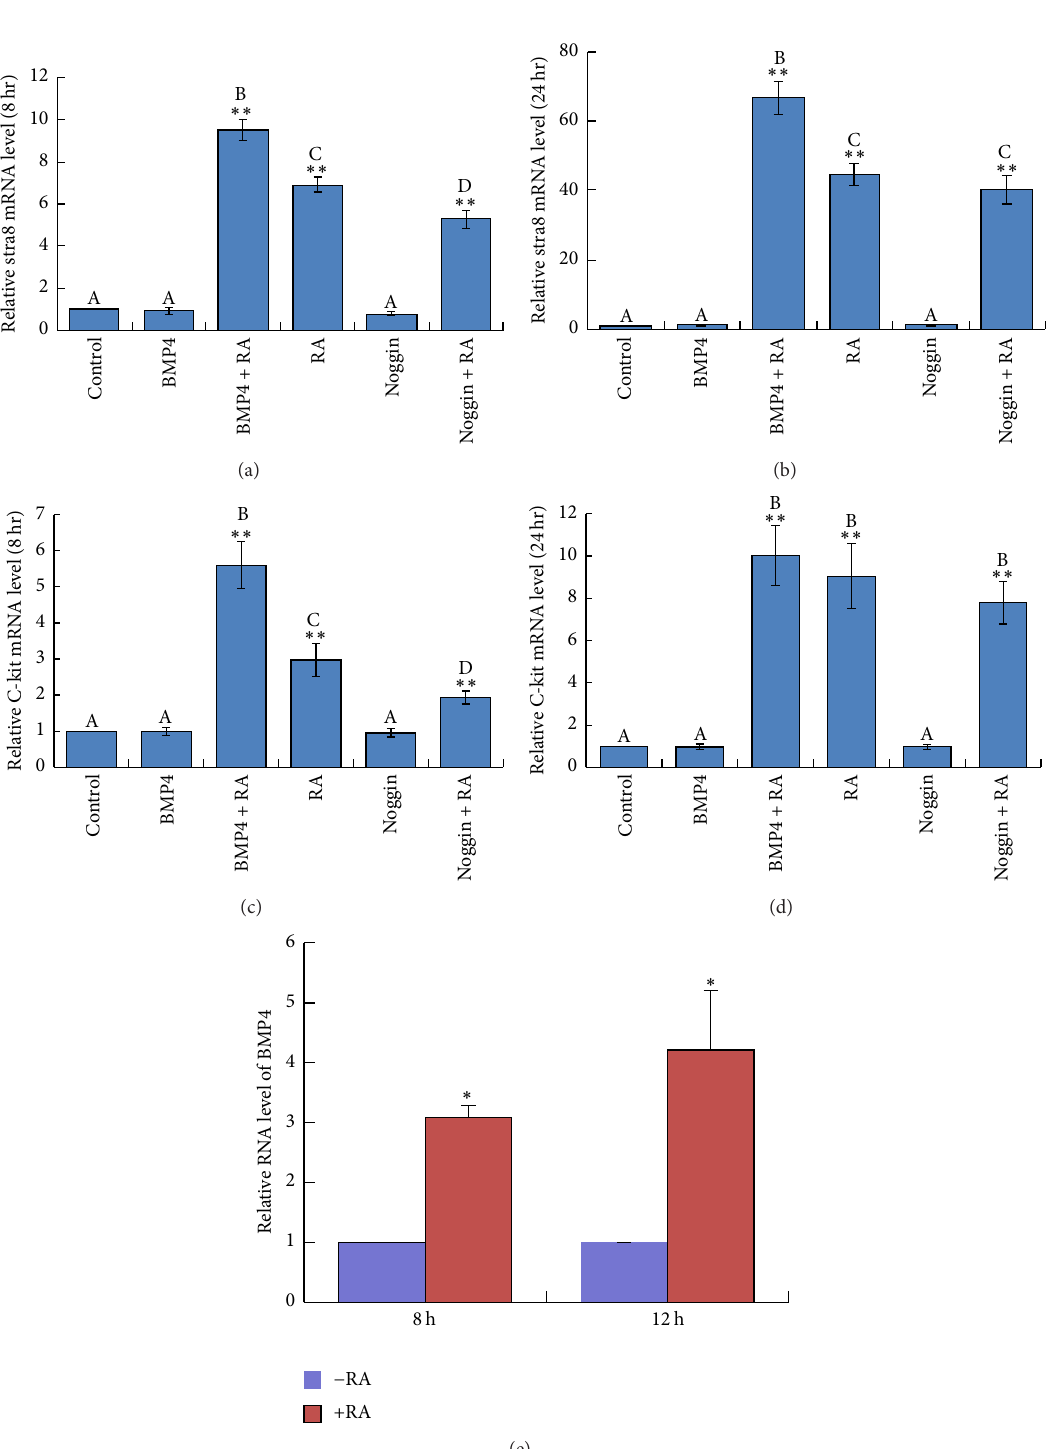
Figure 6: BMP4 induces the expression of Stra8 and c-Kit cooperatively with RA in cultured spermatogonia. (a-b) Real-time PCR analysis of Stra8 expression in cultured spermatogonia pretreated with BMP4 or Noggin and followed by RA stimulation for 8 hours (a) or 24 hours (b). (c-d) Real-time PCR analysis of c-Kit expression in cultured spermatogonia pretreated with BMP4 or Noggin and followed by RA stimulation for 8 hours (c) or 24 hours (d). (e) Real-time PCR analysis of BMP4 mRNA expression in cultured spermatogonia followed by RA alone stimulation for 8 hours and 12 hours. The columns were labelled with A, B, C, and D, which means values are significantly different ( 𝑃 < 0.05 ) among differently labelled groups; ∗ 𝑃 < 0.05 or ∗∗ 𝑃 < 0.01